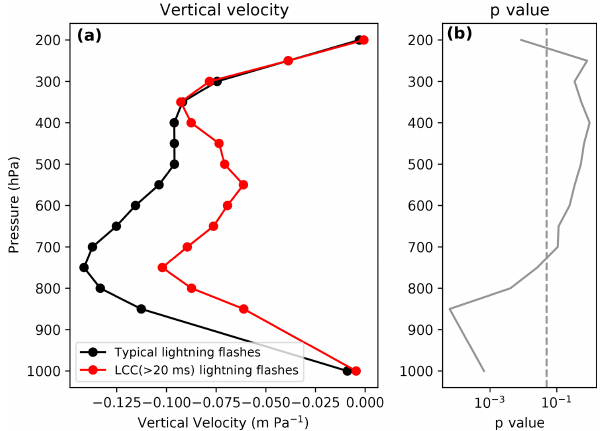
Figure 17. Median vertical velocity profile of typical lightning flashes and LCC( > 20ms) lightning flashes reported by ISS-LIS over Europe between May and September in 2017–2020 (a) . The p value (solid line) representing the probability of equal median be- tween both distributions and mark showing the limit at 0.05 (dashed line) are shown (b) .